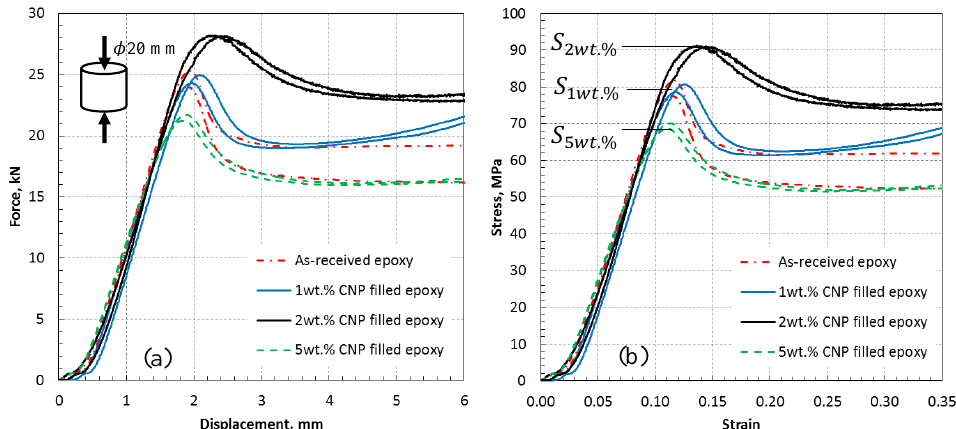
Figure 12. Variation of mechanical response to compression with CNP wt % depicting the maximum threshold at load carrying capacity and maximum stress; ( a ) force versus displacement, ( b ) stress versus strain. Table 2. Variation of mechanical test data with increasing CNP wt %.